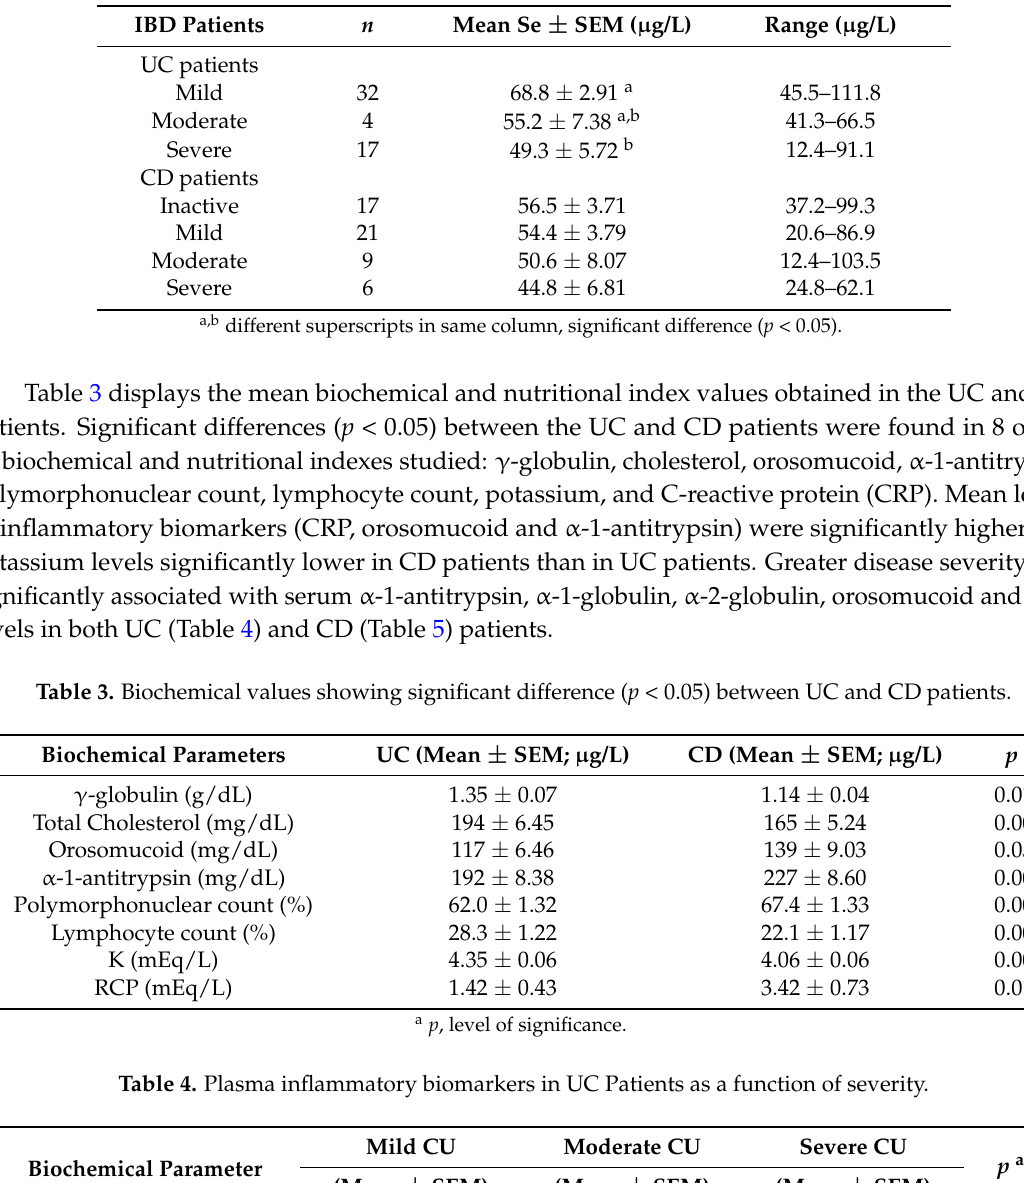
Table 2. Mean selenium concentrations of IBD patients as a function of disease severity.